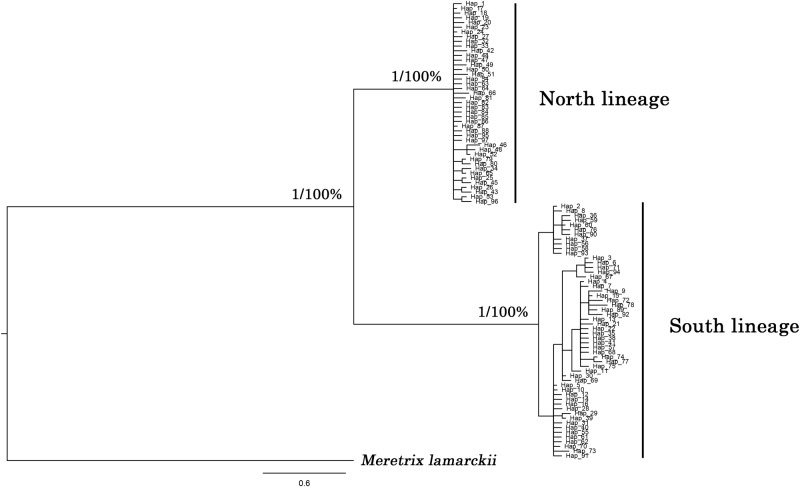
Phylogenetic hypothesis based on COI sequences represented by Bayesian inference method.Bootstrap values were represented near the branches (BI and NJ bootstrap values, respectively).